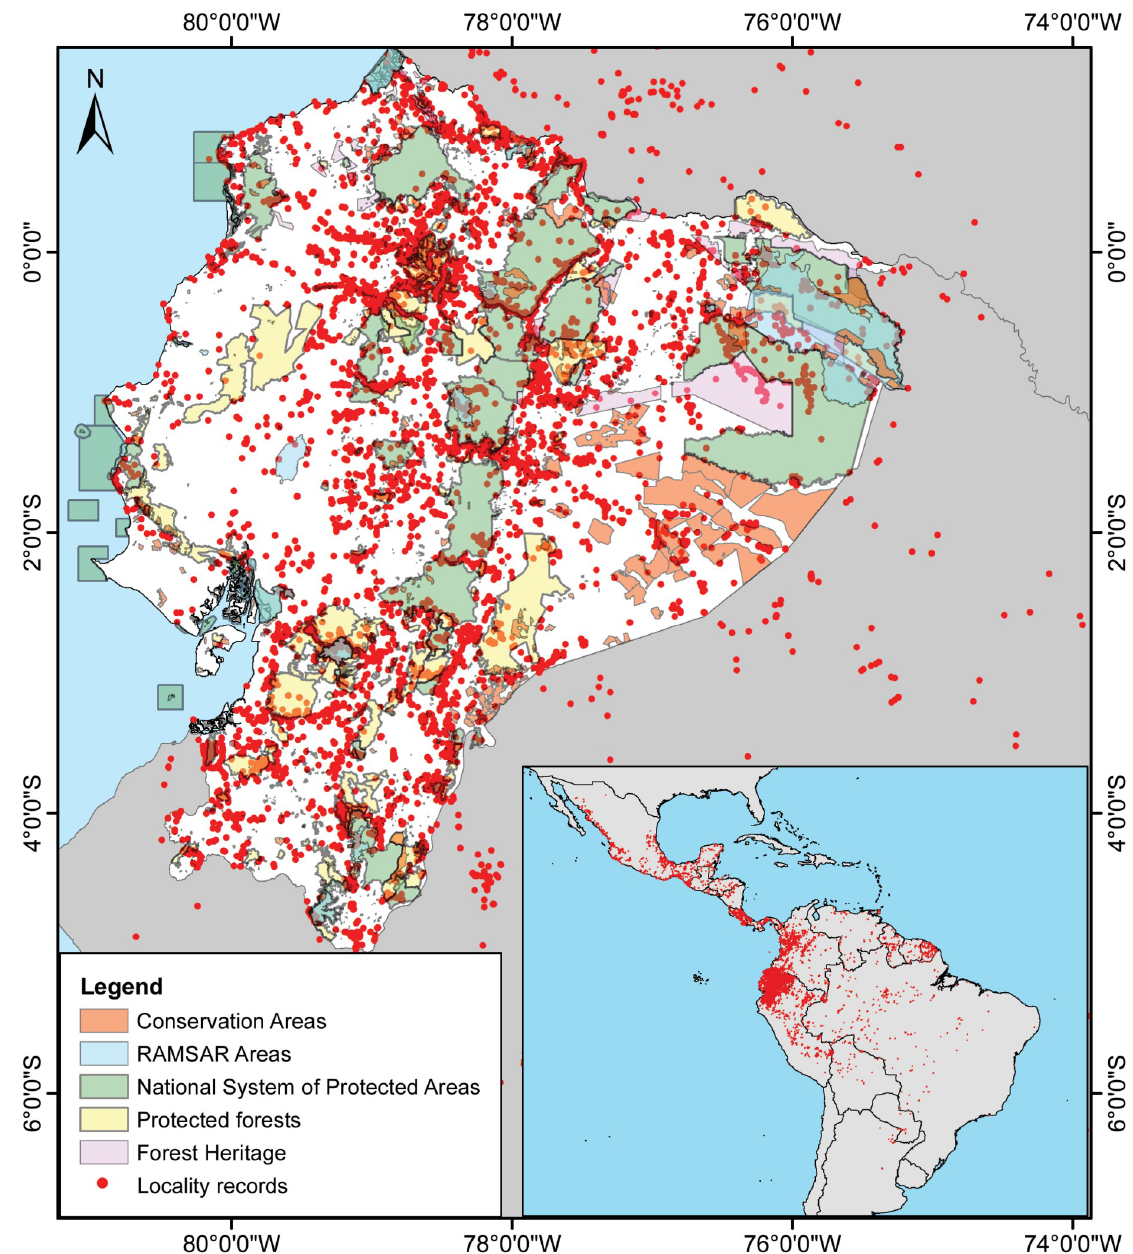
Fig 1. Spatial distribution of records from the amphibian database. A total of 37,328 records from 635 native species (including Rana catesbeiana , an introduced species) assessed for the IUCN Red List of Ecuadorian amphibians. Categories in the legend correspond to the National System of Protected Areas (SNAP, from Spanish acronym) in Ecuador. Details of collections, sources, and databases are provided in the S2